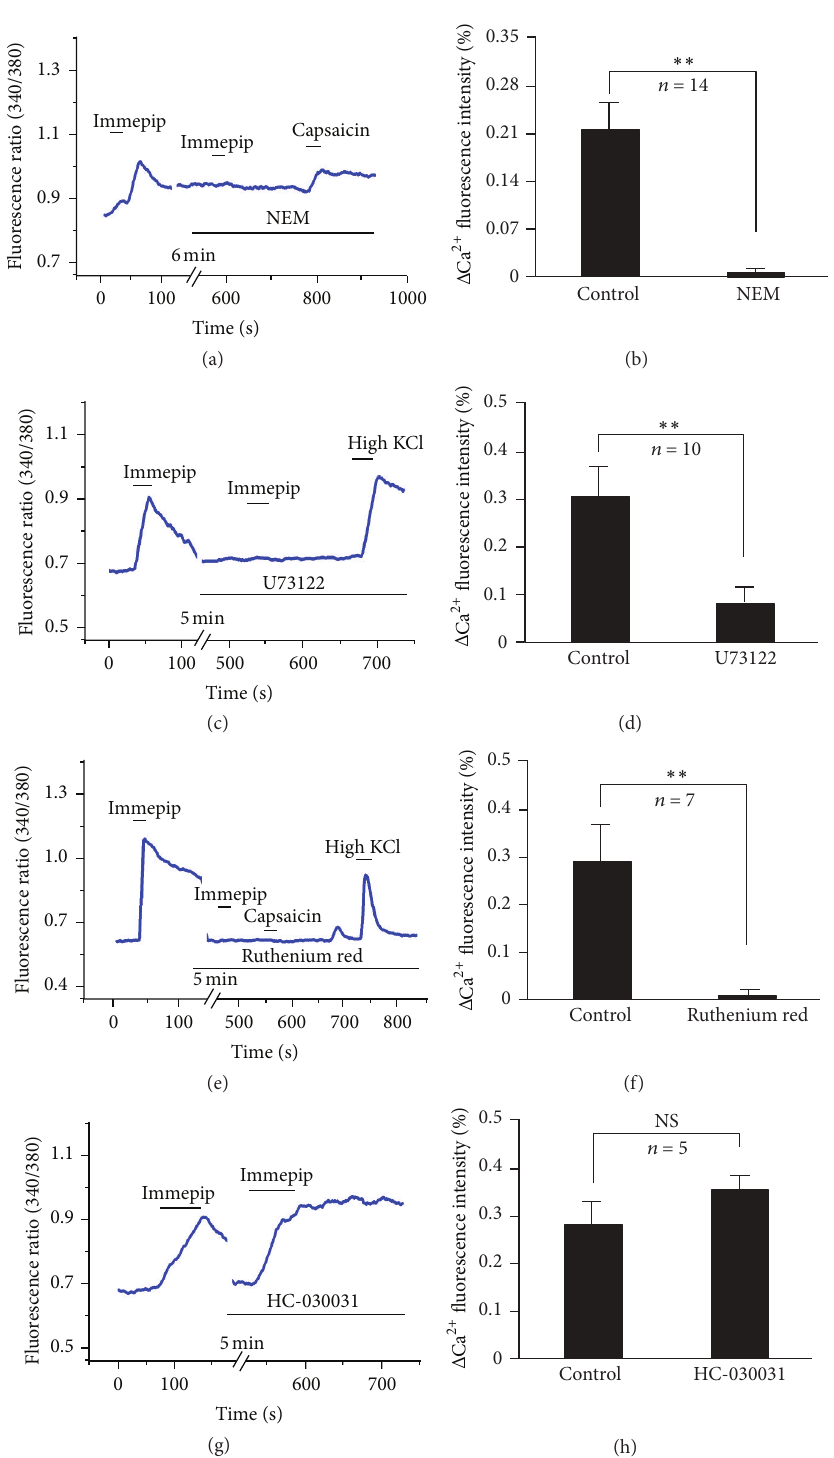
Figure 4: The effects of G protein, PLC, and TRP inhibitor on the immepip-induced increase in [ Ca 2+ ] i of DRG neurons. (a, c, and e) G protein inhibitor NEM ( 𝑁 = 14 ), PLC inhibitor U73122 ( 𝑁 = 10 ), and TRP channels antagonist ruthenium red ( 𝑁 = 7 ) blocked the immepip-induced increase in [ Ca 2+ ] i , but TRPA1 antagonist HC-030031 ( 𝑁 = 7 ) could not block the immepip-induced increase in [ Ca 2+ ] i (g). (b, d, f, and h) Mean changes ( Δ ) 𝑅 (340/380) of the responsive neurons. ∗∗ 𝑃 < 0.05